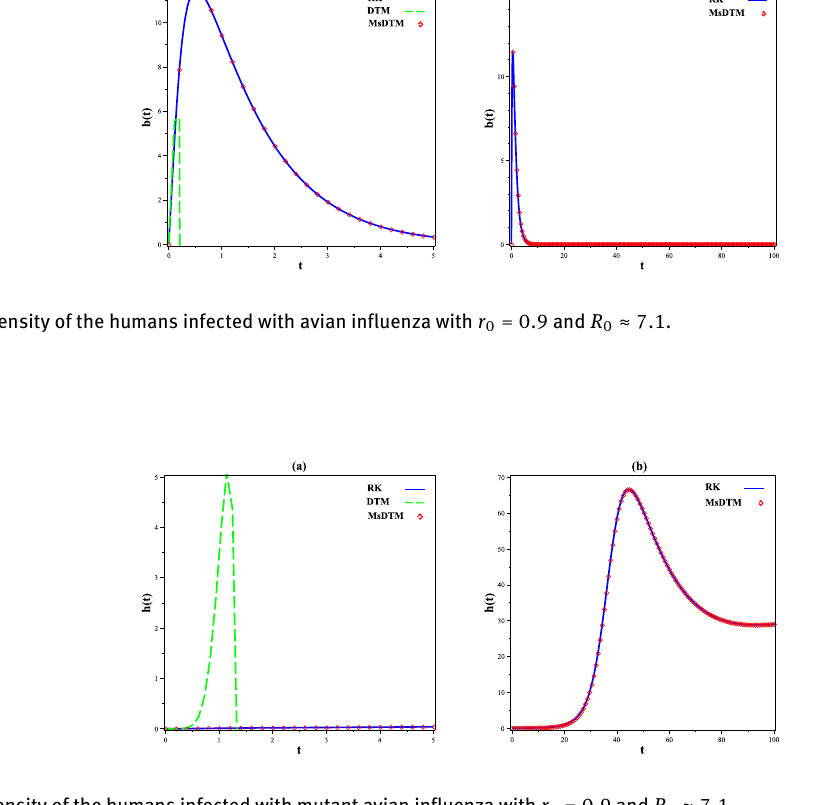
Figure 11: The density of the humans infected with mutant avian influenza with r 0 = 0.9 and R 0 ≈ 7.1 .